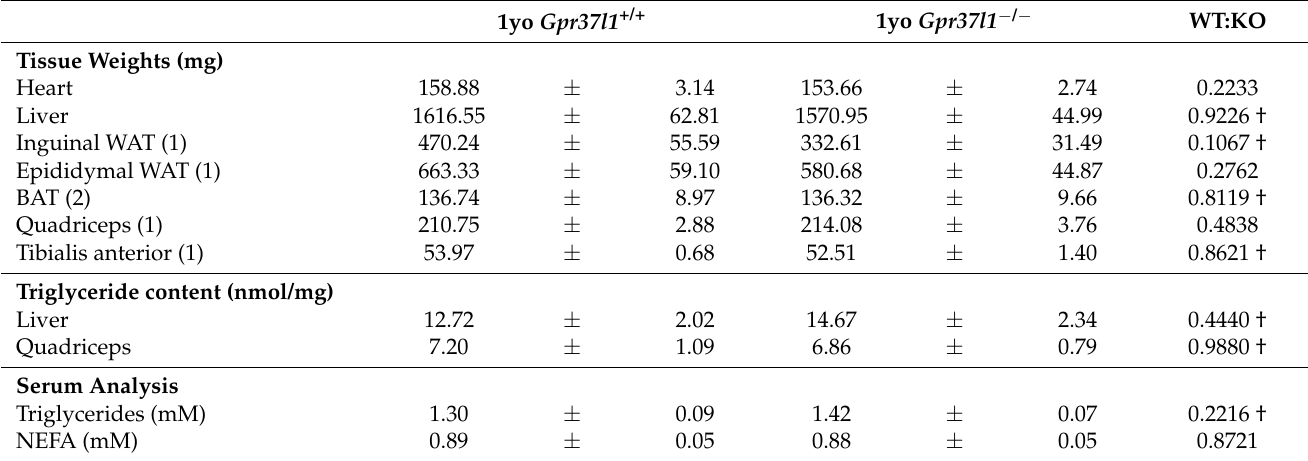
Table 2. One-year-old Gpr37l1 − / − tissue morphometry and triglyceride and NEFA analysis. 1yo Gpr37l1 +/+ 1yo Gpr37l1 − / −